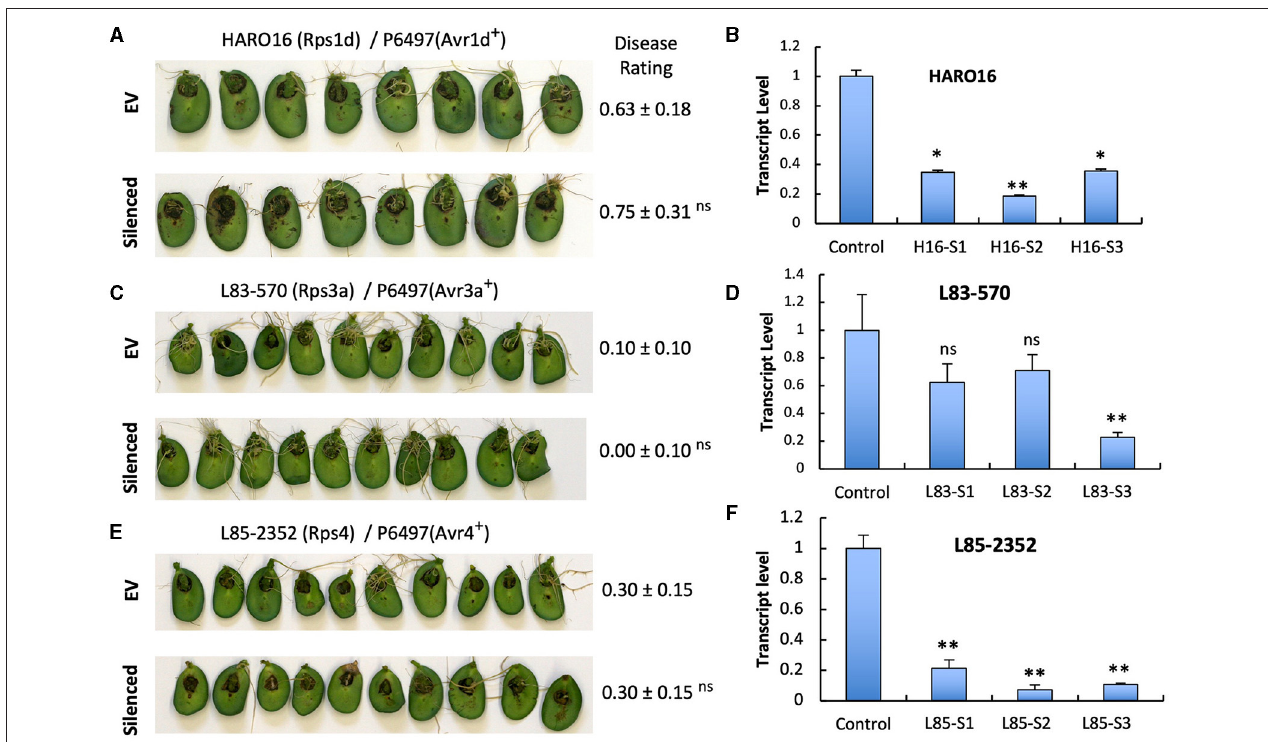
FIGURE 5 | Silencing of GmPUB1 genes does not affect effector recognition by products of the Rps1 -d, Rps3 -a, and Rps4 genes. (A,C,E) Soybean cotyledons carrying Rps1 -a (A) , Rps3 -a (C) , or Rps4 (E) were inoculated with A. rhizogenes harboring the GmPUB1-1 :RNAi vector or pART27GFP empty vector. Six days later, the cotyledons were inoculated with mycelia of P. sojae strains P6497. Cotyledons were photographed 3 days after P. sojae inoculation and disease levels were assessed as in Figure 4 . (B,D,F) Transcript levels of GmPUB1 ( GmPUB1-1 and GmPUB1-2 combined) were measured by qRT-PCR in three individual soybean cotyledons of HARO16 (B) , L83-570 (D) , or L85-2352 (F) inoculated with A. rhizogenes harboring the GmPUB1 -1:RNAi vector. Error bars represent standard errors from three technical replicates. ns, * or ** indicate p > 0.05, p < 0.01 or p < 0.001, respectively, for the difference with the